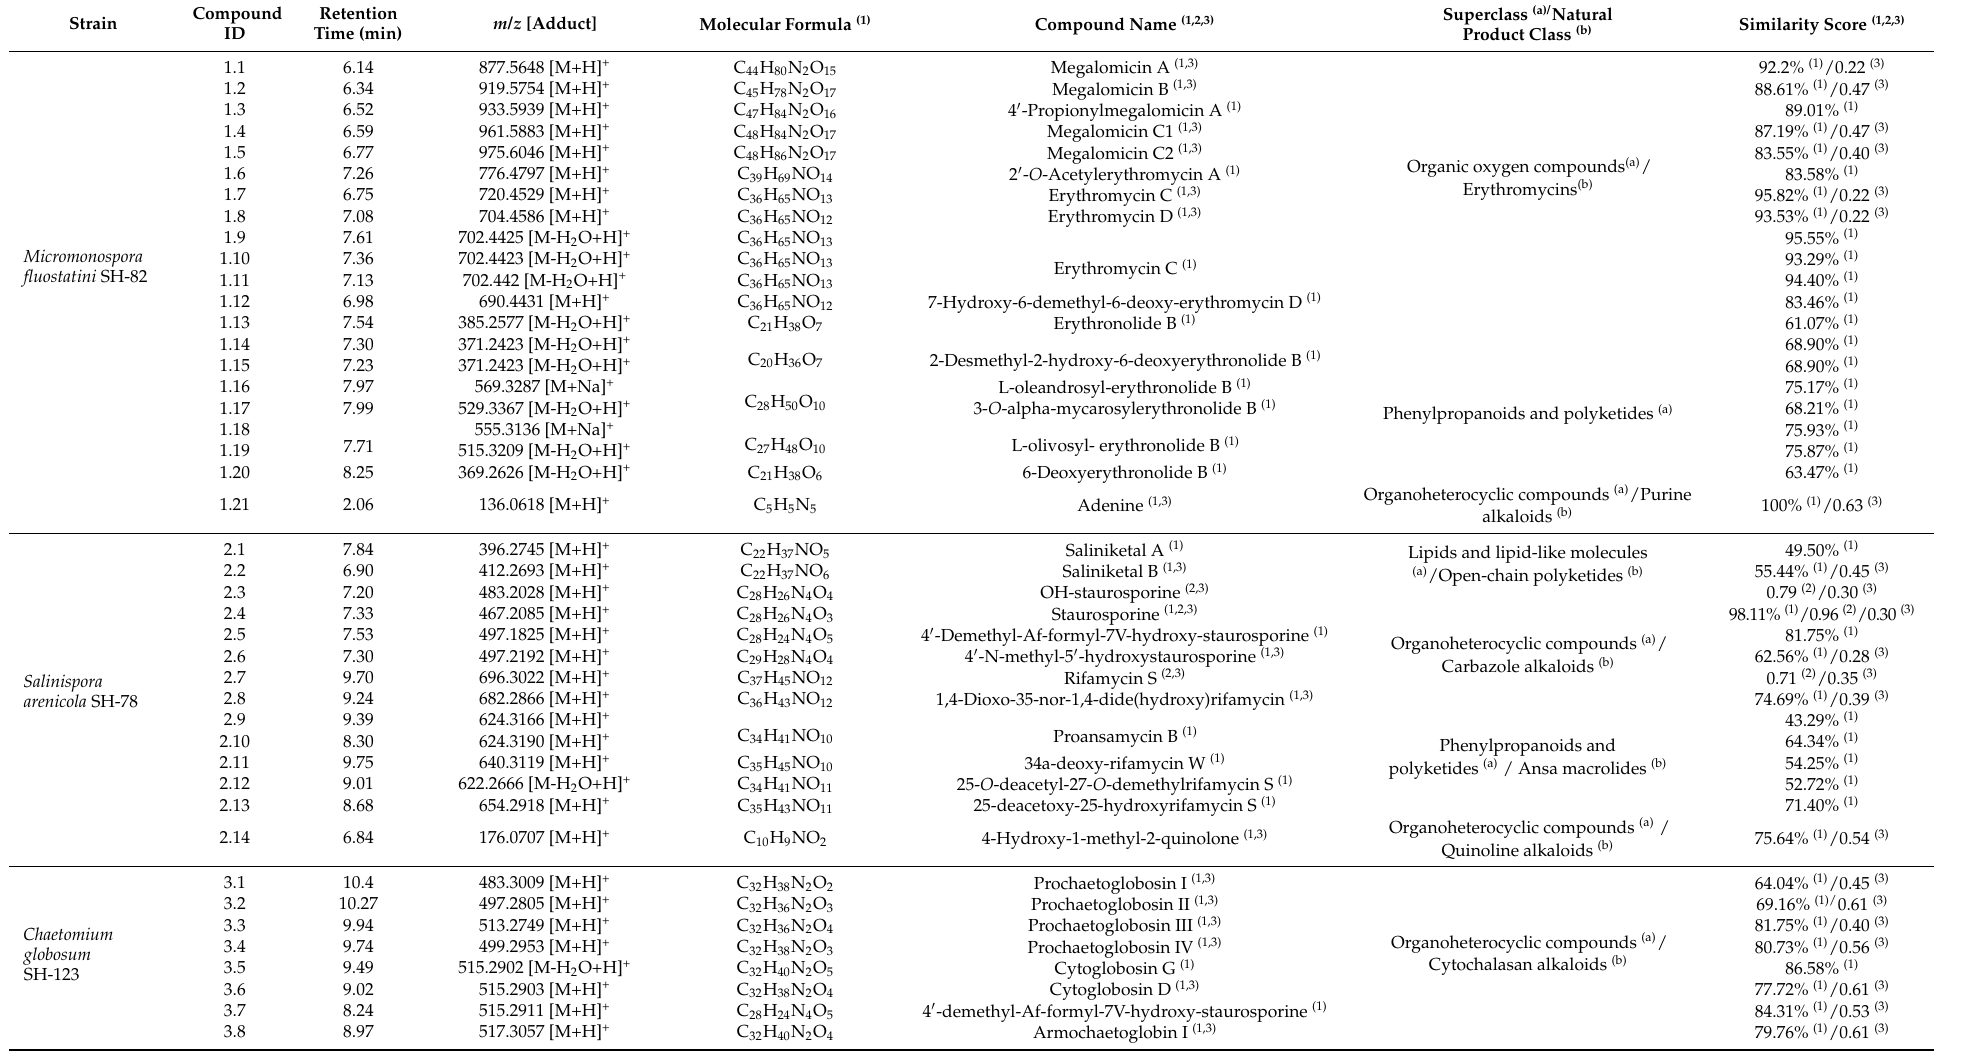
Table 3. Summary table of annotations from the Ion Identity Molecular Network